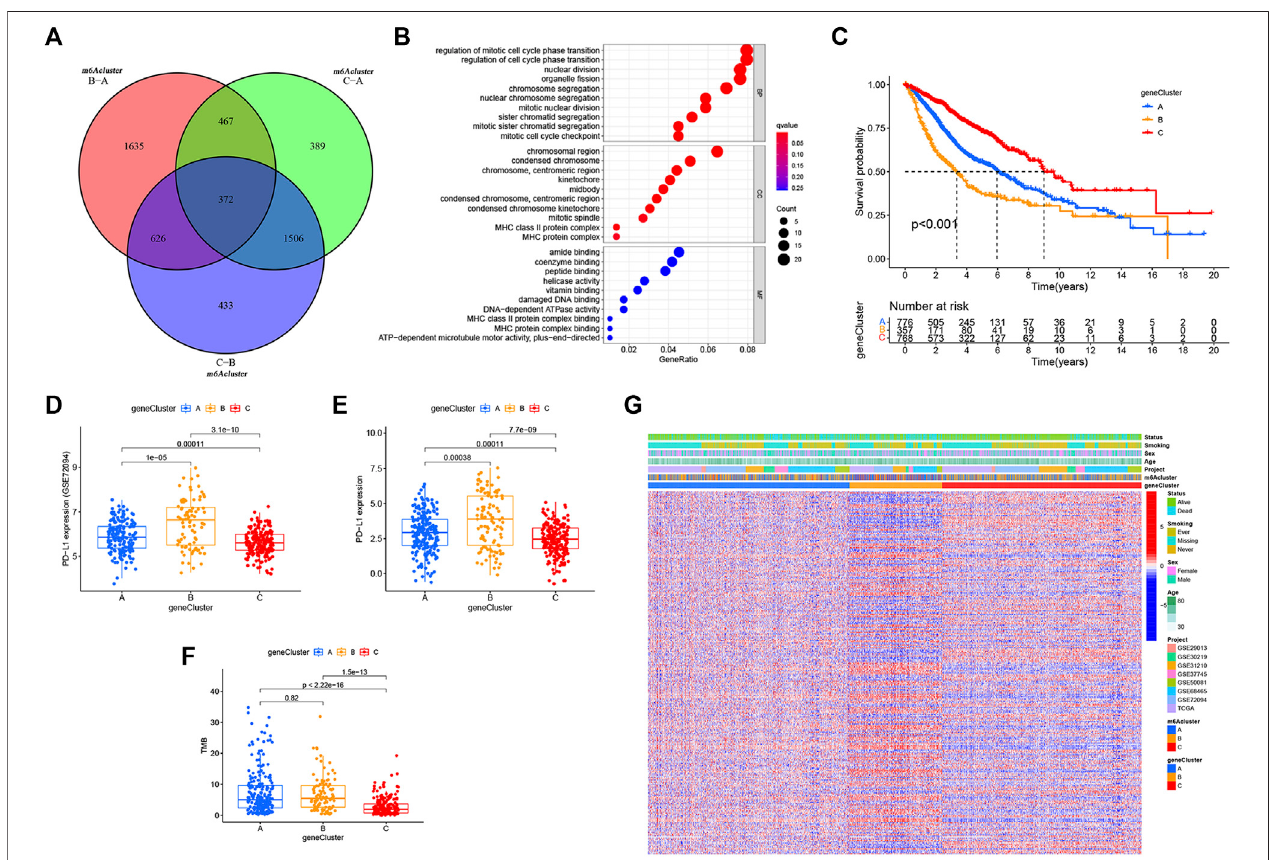
FIGURE 4 | m6A phenotype – related DEGs and functional annotation. (A) Venn diagram of 372 m6A-related DEGs between the three m6A decoration patterns. (B) Functional annotation for phenotype-related DEGs associated with the prognosis using GO enrichment analysis. (C) Estimation of the survival curve of m6A phenotype – relatedgenemarkers by Kaplan – Meier plotter ( p < 0.001,log-ranktest). (D) ExpressiondifferenceofPD-L1 (CD274) inthe three geneclusters inthe GSE72094 cohort. (E) Expression difference ofPD-L1 (CD274)in the three geneClusters in TCGAcohort. (F) Difference inTMB between the three gene clusters inTCGA – LUAD cohort. (G) Overlappingm6Aphenotype – relatedDEGsassociatedwithprognosisasunsupervisedclustering,andthepatientsweredividedintodifferentgenomicsubtypes de fi ned as gene clustering A – C. Gene signature subtypes, m6A clusters, items, age, gender, smoking status, and life status were used as patient